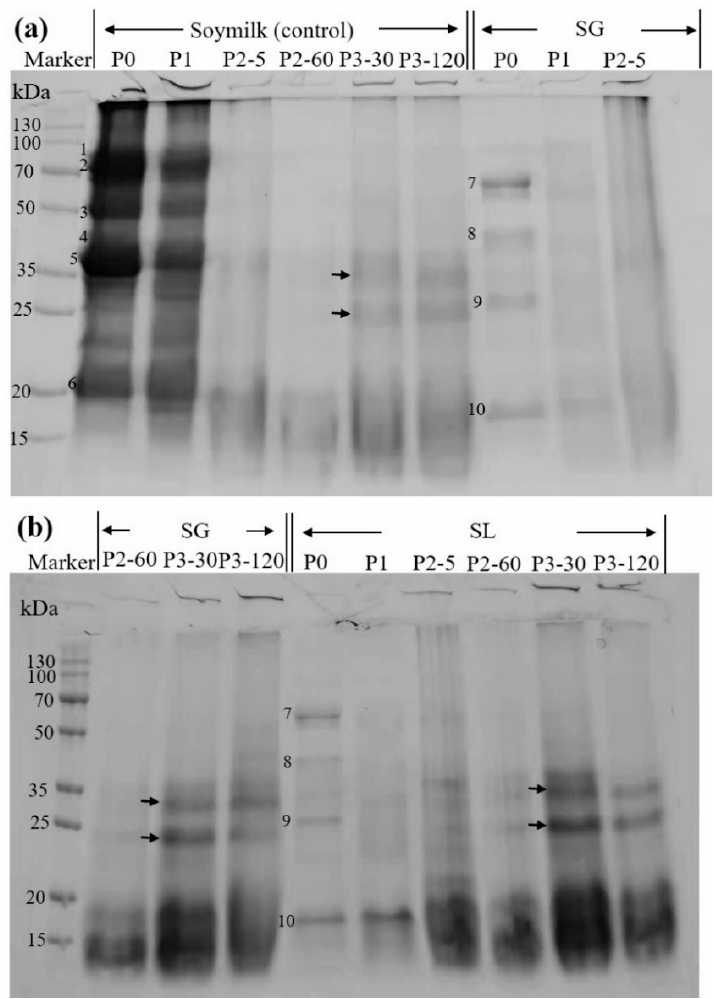
Figure 4. SDS-PAGE profiles of proteins that were taken from the supernatant at various stages of in vitro GIS. Predominant bands seen both before and after in vitro GIS were denoted by numbers 1–10. ( a ) Soymilk and SG digesta, ( b ) SL digesta. P0 represents the sample before in vitro GIS digestion; P1 represents the sample after buccal digestion; P2-5 and P2-60 indicate samples collected at 5 min and 60 min of gastric digestion, respectively; and P3-30 and P3-120 indicate samples collected at 30 min and 120 min of intestinal digestion, respectively.